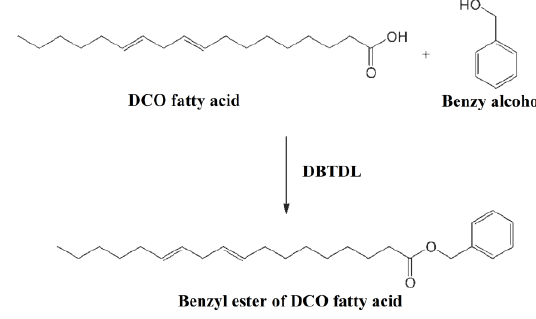
Figure 23. Synthesis of cardanol esters.